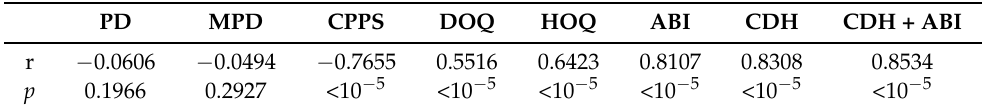
Table 2. Pearson Correlation Coefficients, r ( p -values), between the breathiness rating and the selected parameters (PD: Pitch Difference, MPD: Pitch Difference in Mel scale, CPPS: Smoothed Cepstral Peak Prominence, DOQ: Open Quotient with DECOM method, HOQ: Open Quotient with Howard method, CDH: CPPS + DOQ + HOQ, CDH + ABI: CPPS + DOQ + HOQ + ABI).